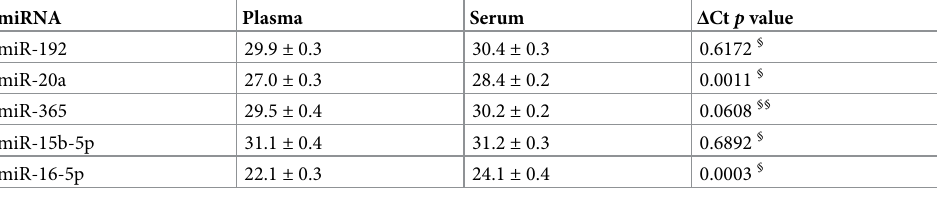
Table 2. Cycle threshold values (mean ± SEM) for microRNA derived from feline plasma and serum samples of all groups (control + PKD).